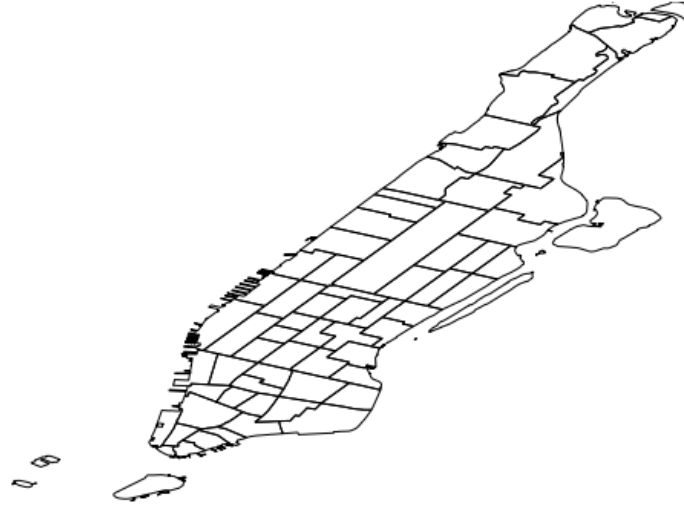
Figure 4. Manhattan taxi zones. Each polygon represents a particular